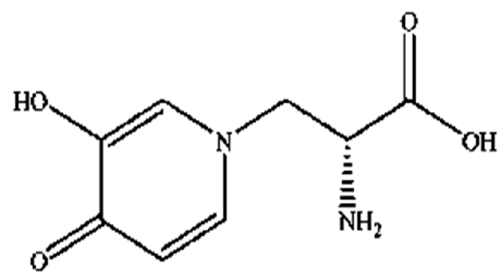
Figure 1. Structure of mimosine.